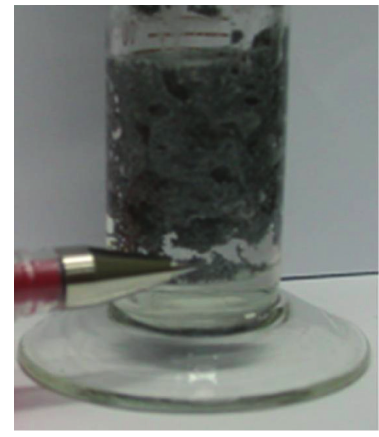
Figure 12: Successful floating of zinc sol.